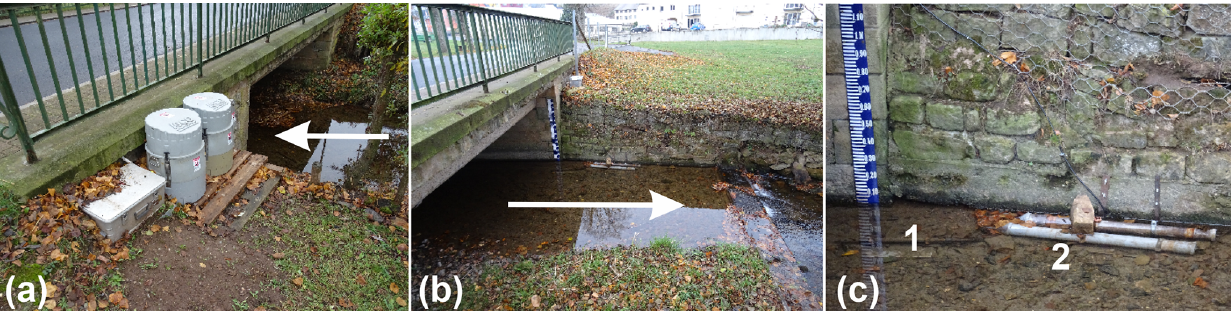
Figure 2. Pictures of the experimental set-up at the study location. (a) Automatic samplers installed upstream of the bridge. (b) An overview of the installation of the Phillips samplers downstream of the bridge. The arrow denotes streamflow. (c) A close-up of the turbidity meter (1) and the Phillips samplers